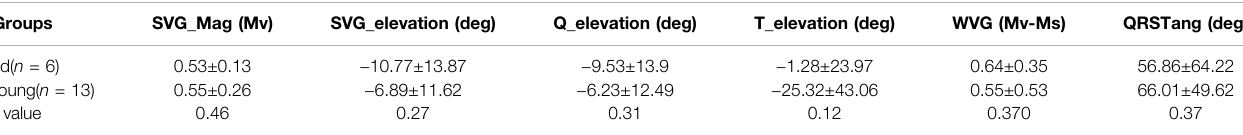
TABLE 7 | Age-dependent effects on VCG parameters using NES-AN approach.